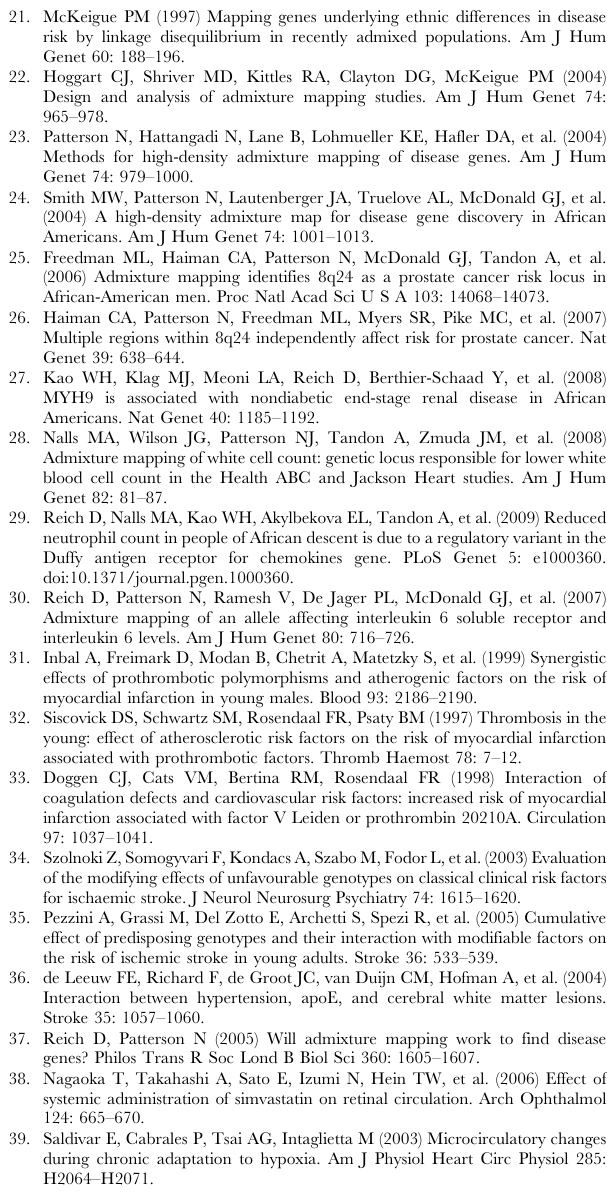
Figure S1 Genome-wide admixture mapping scans for loci affecting retinal arteriolar caliber in hypertensive individuals. Figure S2 Posterior probability distribution for the position of the locus of retinal venular caliber. Table S1 Summary of the initial admixture scan results by chromosome.